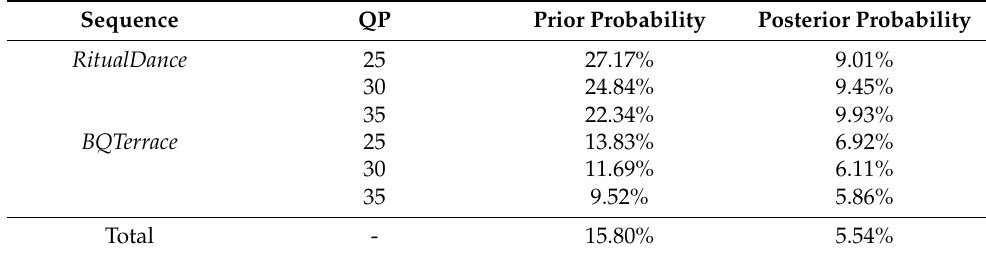
Table 1. Prior and posterior probability according to the conditions of upper CU.